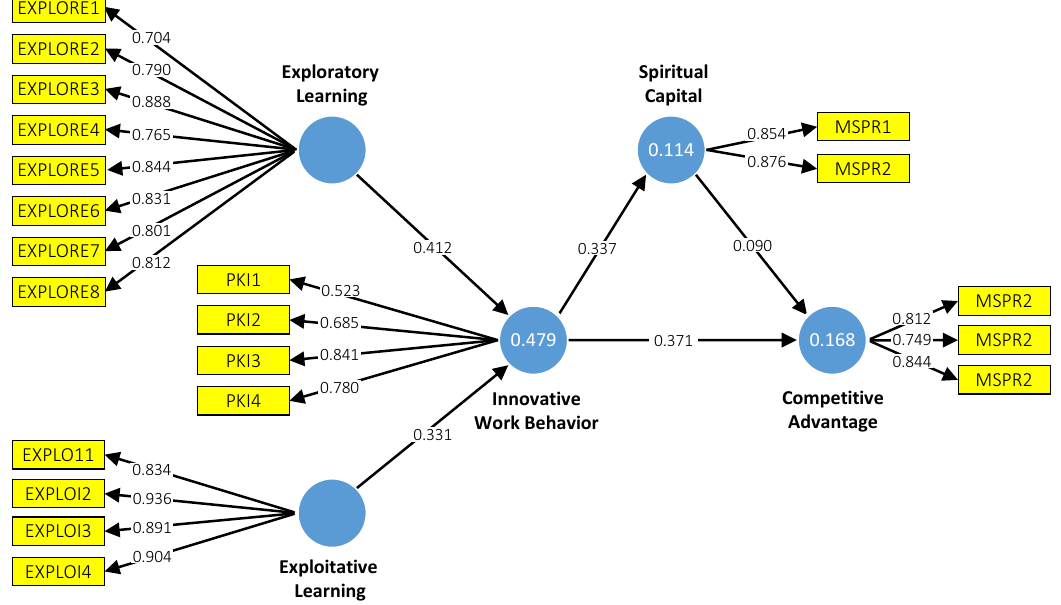
Figure 1. Research model